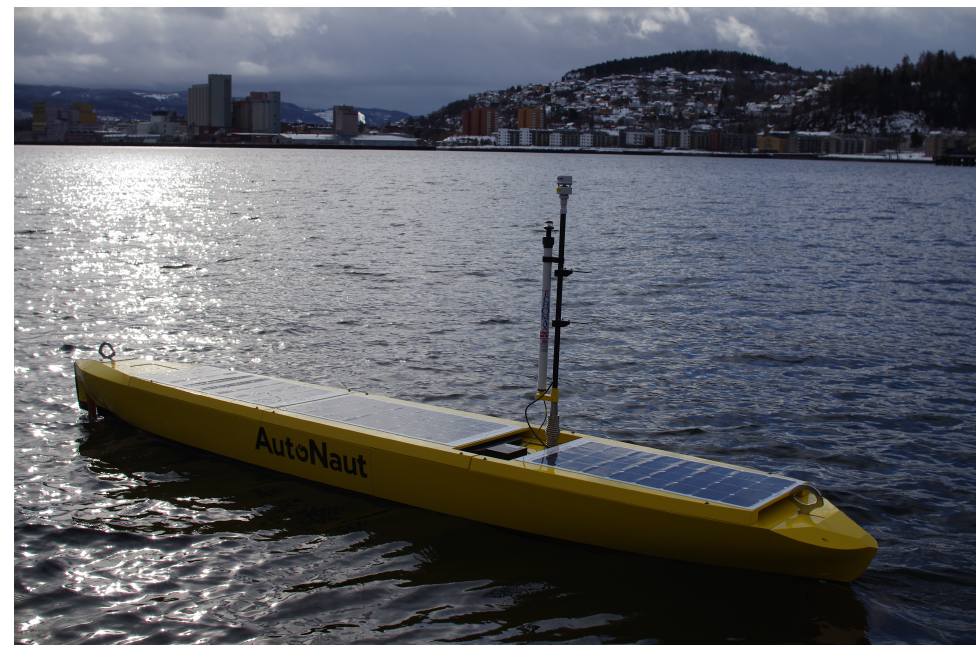
Figure 3. NTNU AutoNaut during operations in